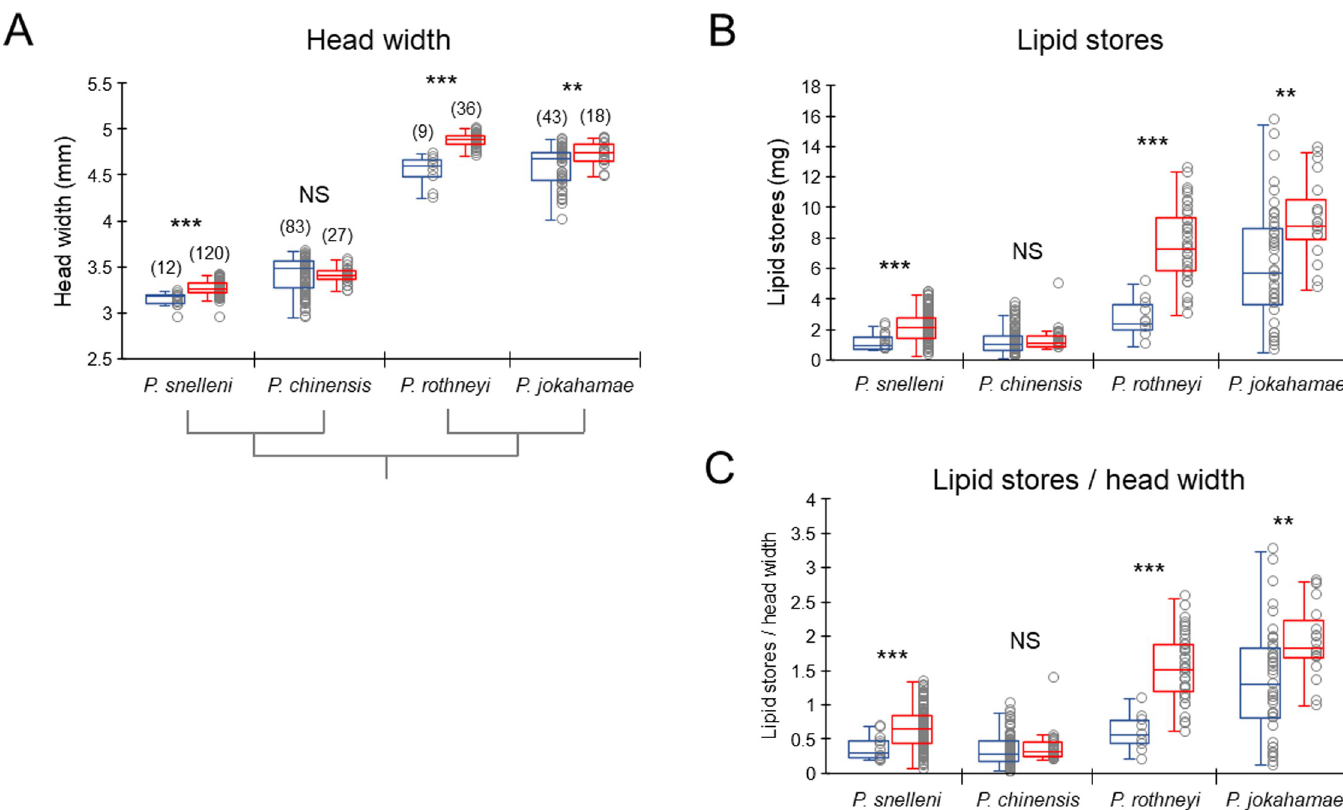
Fig 1. Head width, lipid stores in the abdomen and standardized lipid stores of newly emerged workers and gynes in four species of Polistes paper wasps. (A) Head width, (B) lipid stores in the abdomen and (C) ratios of lipid stores to head widths. Blue and red box plots indicate workers and gynes, respectively. Numbers in parentheses in the graph indicate the number of samples examined. The number of samples examined for the lipid stores and standardized lipid stores is the same as those for head width. Asterisks in the graph indicate significant differences between workers and gynes ( �� : P < 0.01, ��� : P < 0.001, NS: not significant, P > 0.05). The phylogenetic relationship is indicated below the X-axis in